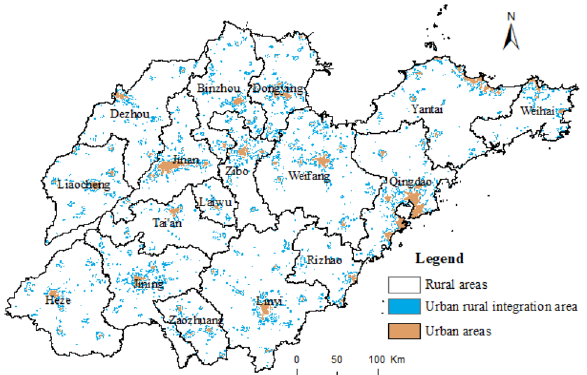
Figure 1. Urban and rural areas of Shandong province based on nighttime light data. This figure was created with ArcGIS 10.5 (URL: http:// www. esri.